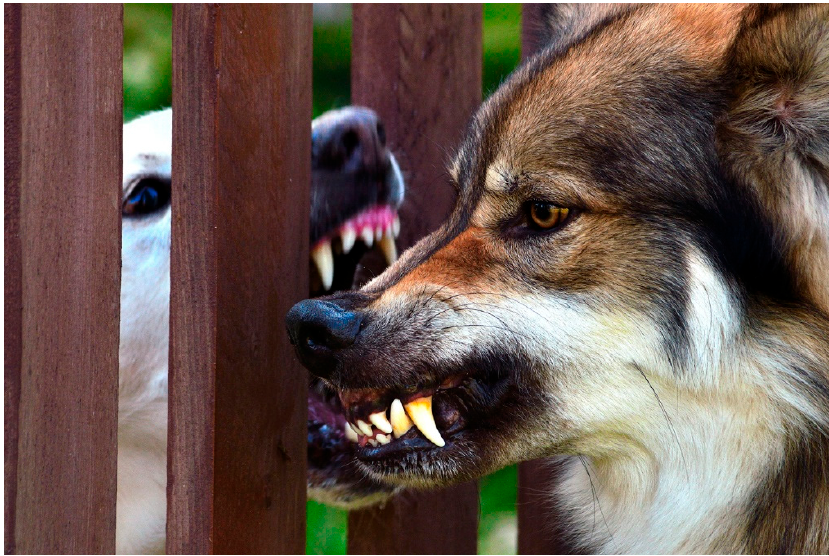
Figure 6. In this photo, the tension is very high: the Czech wolf is asking the other dog to back off, showing his desire to communicate; he is threatening the white dog, but his look is not directly at the other dog. The white dog instead is much more direct and intense (picture taken from a video footage).